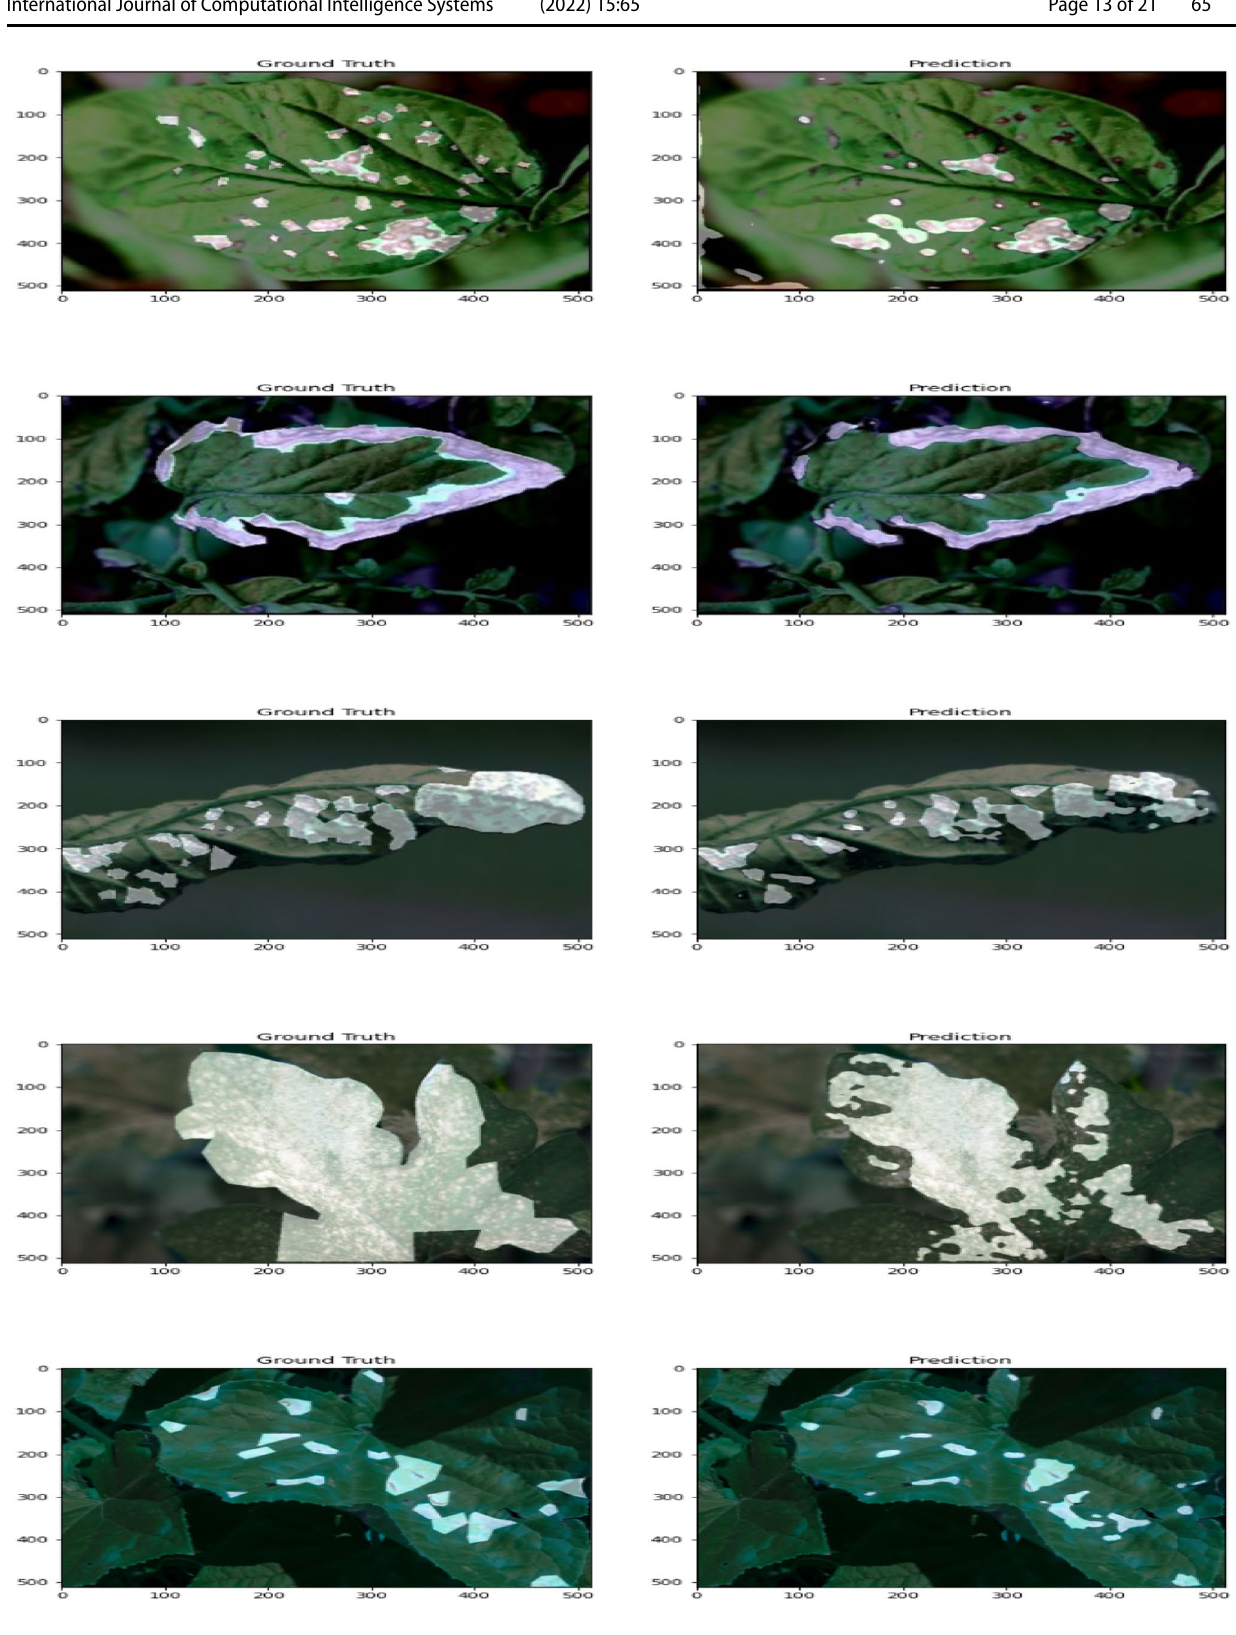
Fig. 8 Some Ground Truth against prediction samples obtained by Deep Lav3